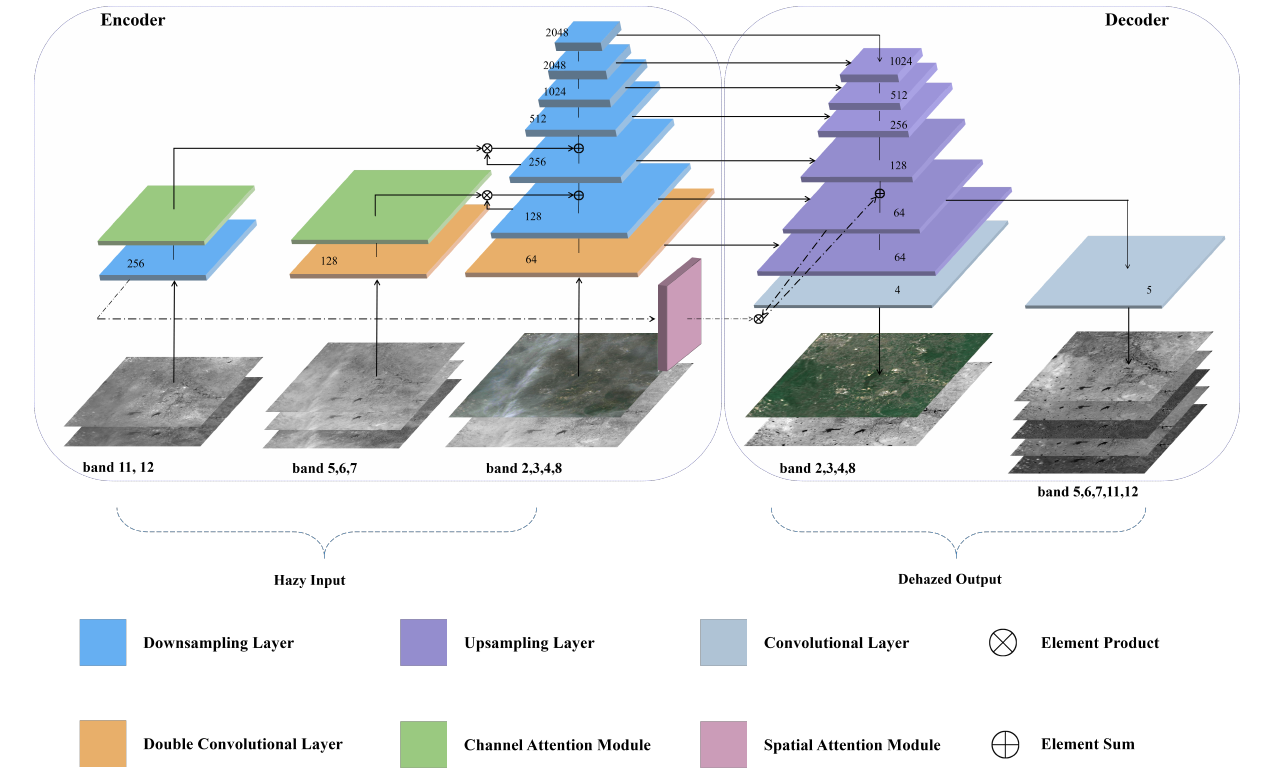
Figure 3. The architecture of the proposed